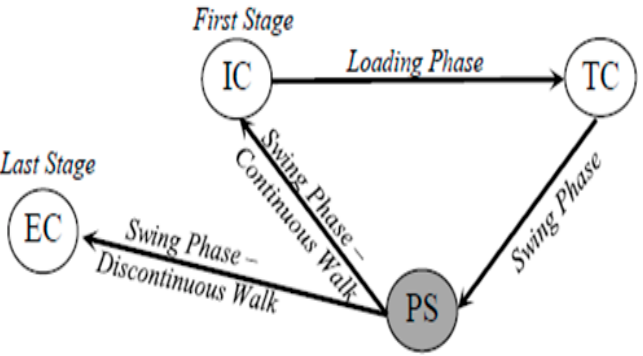
Figure 5. State machine diagram outlining algorithm logic for a single stride. Algorithm starts by detecting the first IC point when the cane strikes the ground.